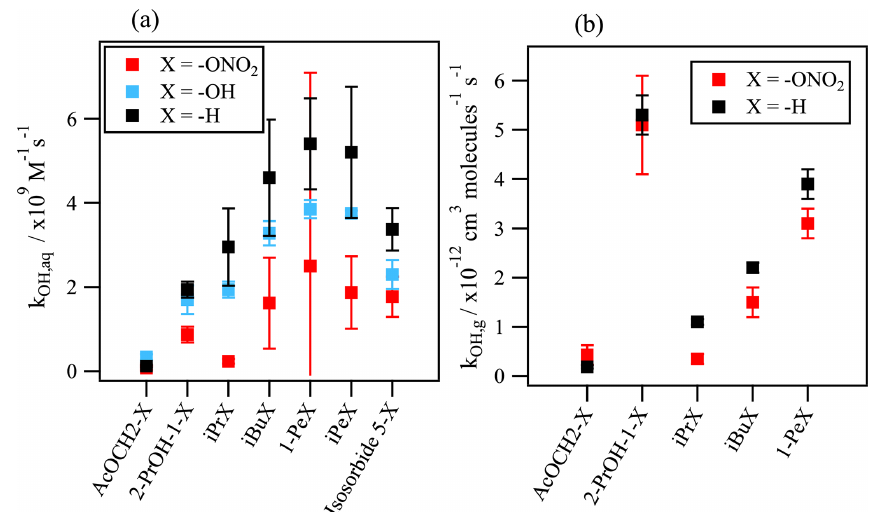
Figure 5. Comparison between the k OH values for organic nitrates, the corresponding alcohols, and non-substituted homolog compounds (a) in the aqueous phase and (b) in the gas phase. Aqueous-phase k OH values were taken from Reuvers et al. (1973) and Adams et al. (1965) for alcohols; Getoff (1991) and Rudakov et al. (1981) for H-substituted compounds; and the predictions using the SAR for hydroxy acetone and the –OH and –H substituted homologs of isosorbide 5-mononitrate. Gas-phase k OH values were taken from Atkinson et al. (1982); Atkinson and Aschmann (1989); Becker and Wirtz (1989); Bedjanian et al. (2017); Suarez-Bertoa et al. (2012); Talukdar et al. (1997); Treves and Rudich (2003); and Zhu et al. (1991) for organic nitrates as well as from Atkinson et al. (1997, 1992) and Atkinson (2003) for H-substituted